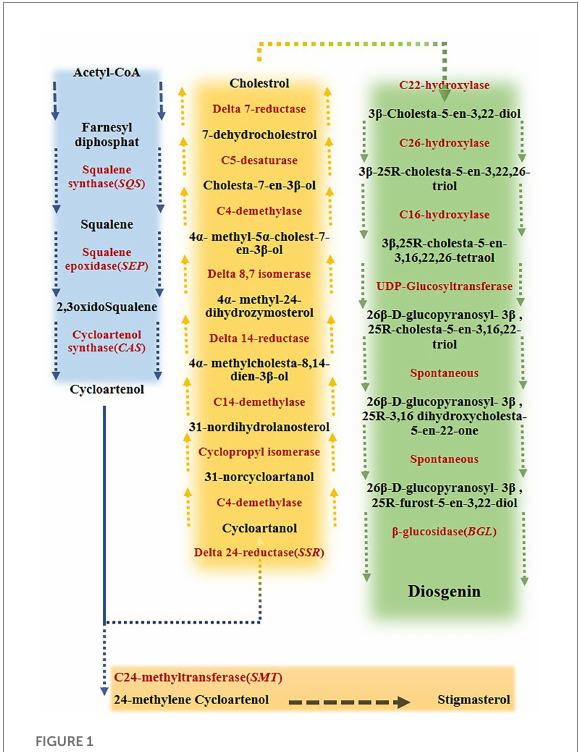
FIGURE 1 Biosynthesis pathway of diosgenin from farnesyl diphosphate in fenugreek. Acetyl-coenzyme A (acetyl-CoA) converts to cycloartenol via a series of multiple reactions. Cycloartenol converts to either cycloartenol, leading to cholesterol formation, or 24 methylene cycoartanol, leading to stigmasterol. This branch-point has a great influence on disogenin biosynthesis. Cholesterol then converts to 3ß -cholesta- 5-en- 3, 22-diol, which ultimately results in diosgenin production (Mohammadi et al.,